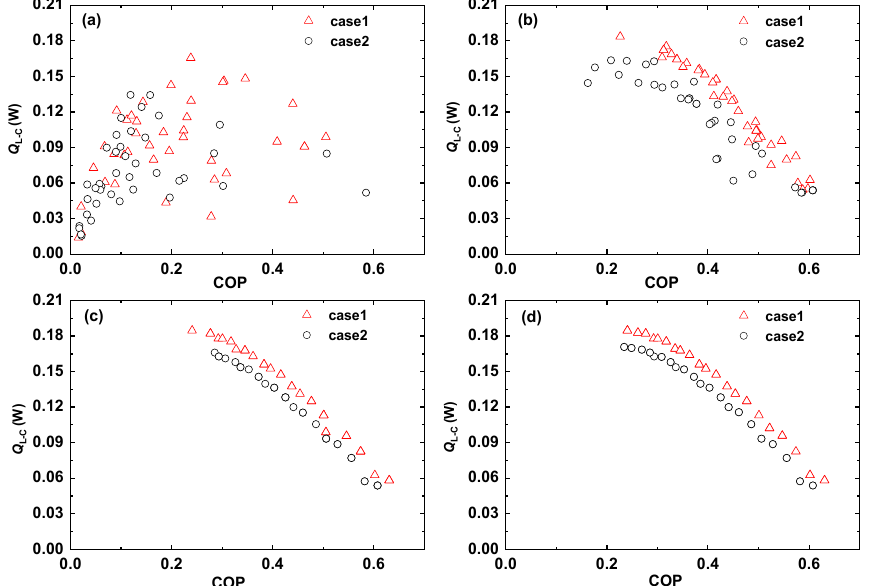
Figure A1. Comparison of distribution of Pareto fronts between case 1 and case 2: ( a ) the first generation; ( b ) the fourth generation; ( c ) the tenth generation; and ( d ) the eightieth generation. In case 1, k Ce is determined by Equation (A1). In case 2, k Ce is determined by Equation (A2).